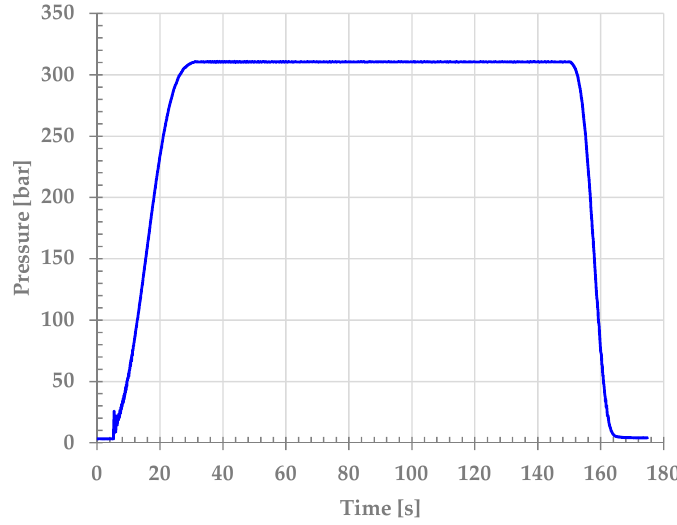
Figure 8. Proof pressure test: load profile.